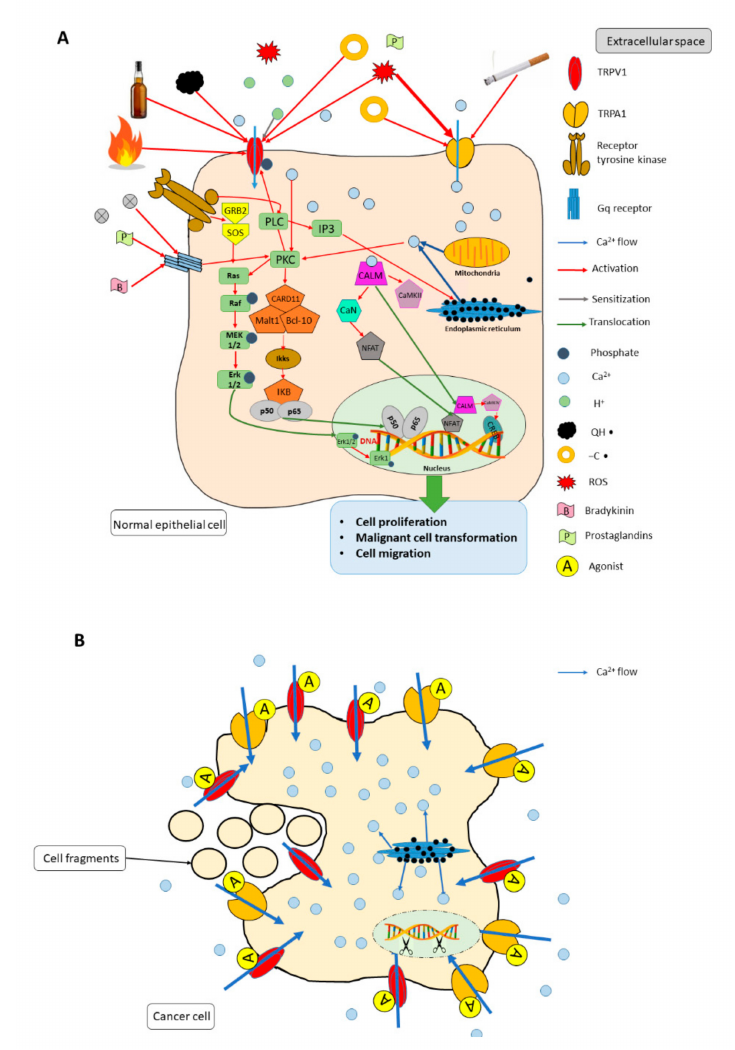
Figure 1. The complex role of transient receptor potential vanilloid 1 (TRPV1) and ankyrin 1 (TRPA1) ion channels in normal epithelial cell ( A ) and cancer cell ( B ). Panel A represents the TRPV1-, TRPA1-mediated signal transduction pathways of potentially carcinogenic exogenous compounds as well as endogenous ligands. Panel B illustrates the antitumor e ff ect of TRPV1, TRPA1 receptor agonists on a cancer cell. Abbreviations: TRPV1: transient receptor potential vanilloid 1;